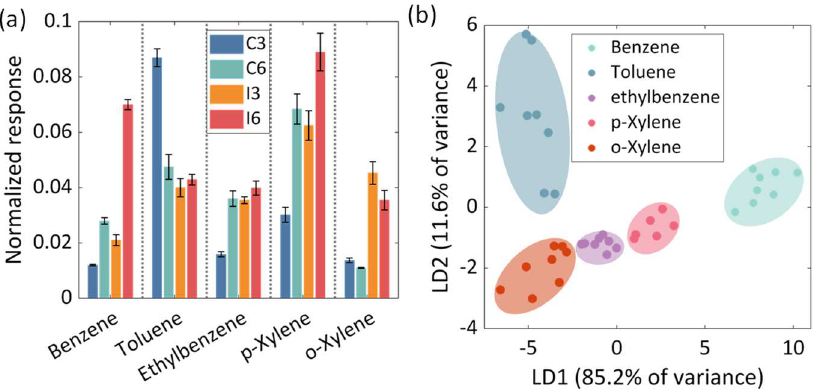
Figure 7. ( a ) Sensors’ response to various BTEX at a concentration of 100 ppb. ( b ) Linear Discriminant Analysis (LDA) scores using responses of the 4 SnO 2 -based gas sensors. For all tests, 2 min. exposition time, 15 min. recovery time, and 100 mL min −1 flow rate were applied.